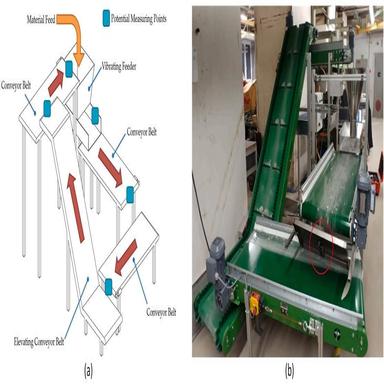
A Concept Sketch (a) and the actual circulation test bench used for this investigation (b).